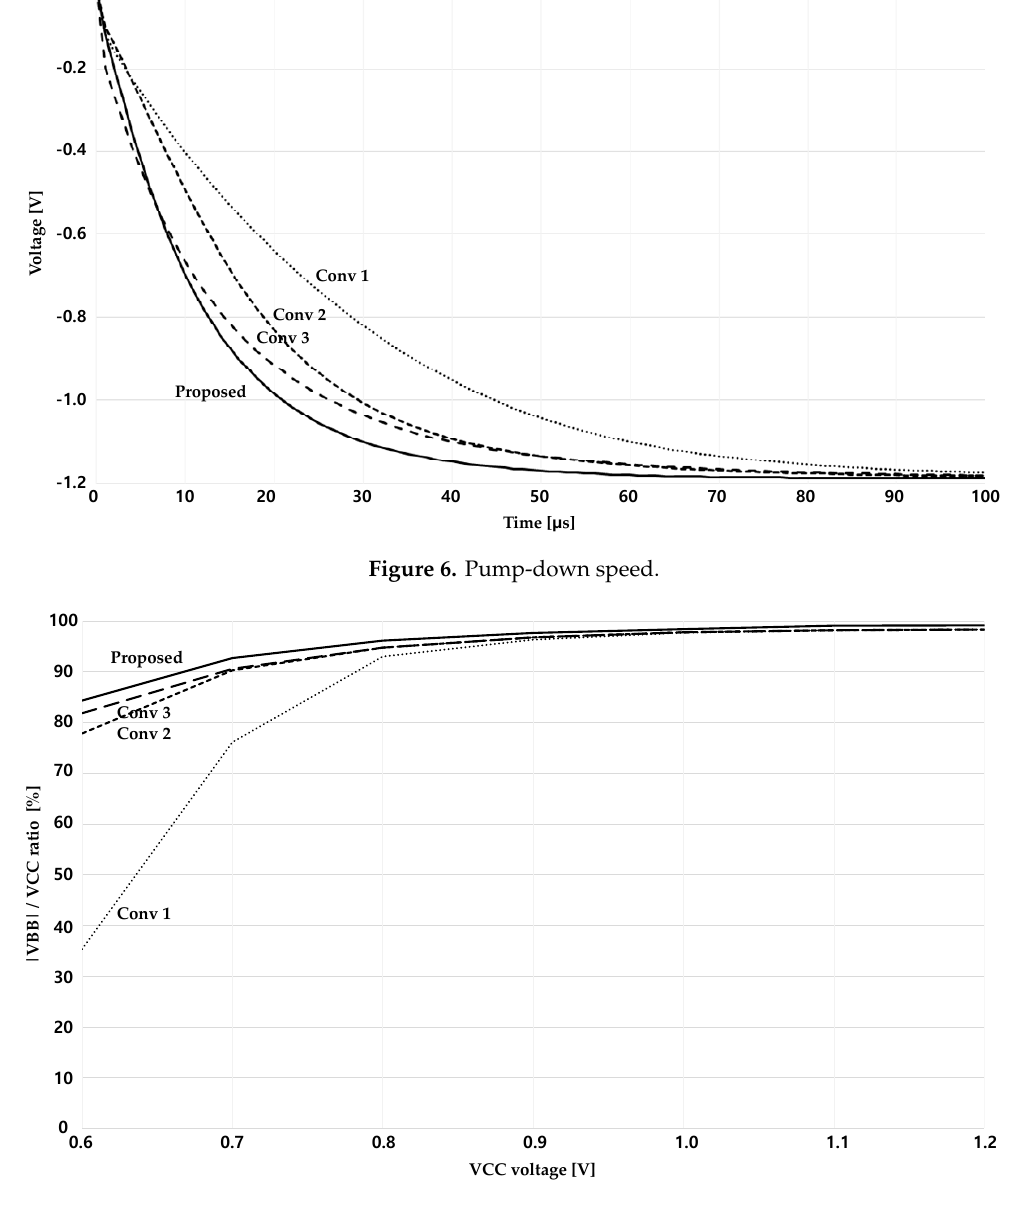
Figure 7. |VBB|/VCC ratio. Figure 7. | VBB |/ VCC